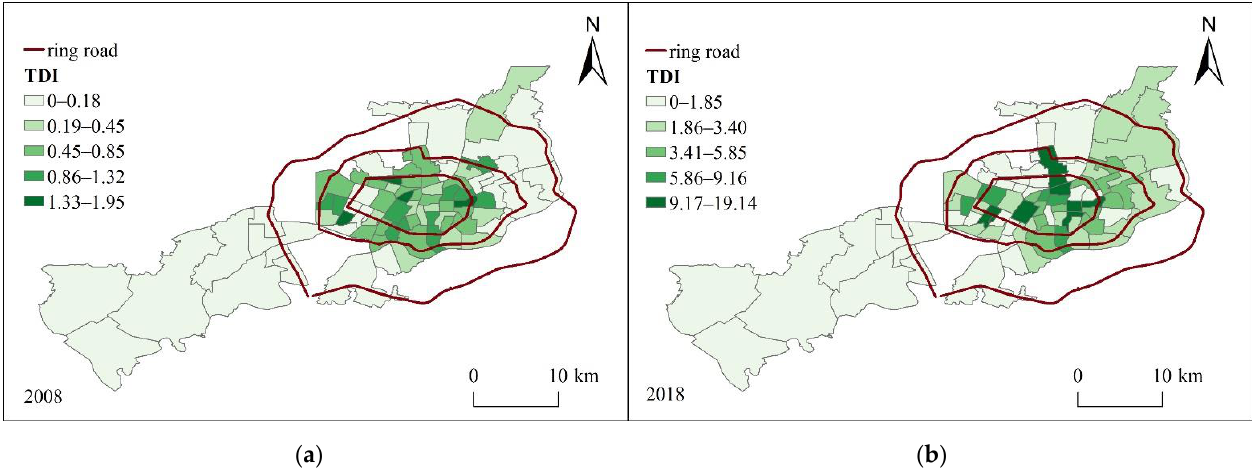
Figure 8. TDI of public toilets in Shenyang: ( a ) distribution of TDI in 2008; ( b ) distribution of TDI in 2008.